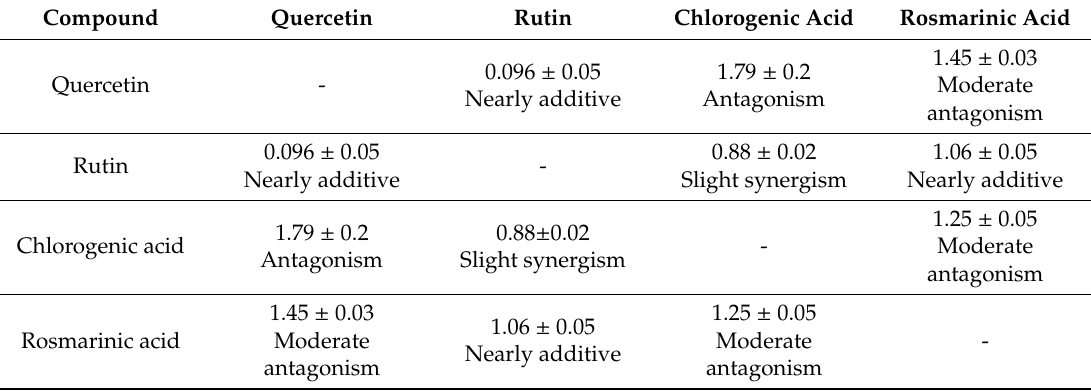
Table 5. CI (Combination Index) value between polyphenolic mixtures. Scale according to Chou, 2006 [39], n =